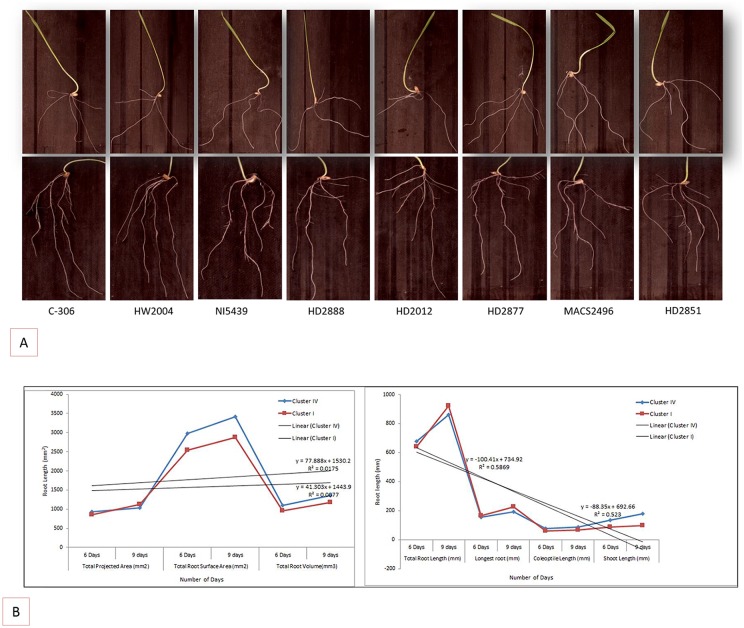
Root traits studied at seedling stage.(A) Root distribution pattern analyzed in drought tolerant and susceptible genotypes grown under well-watered conditions in petri dishes at the interval of 6 and 9 days. (B) Relationships between root traits measured at 6 and 9 days old seedling estimated from two Clusters (I and IV) of wheat genotypes a. Total root length, Longest root, Coleoptile length and Shoot length. Total Projected area, Total Surface area and Total root volume. The solid lines indicate the best fit regression line and 95% confidence length intervals, respectively.